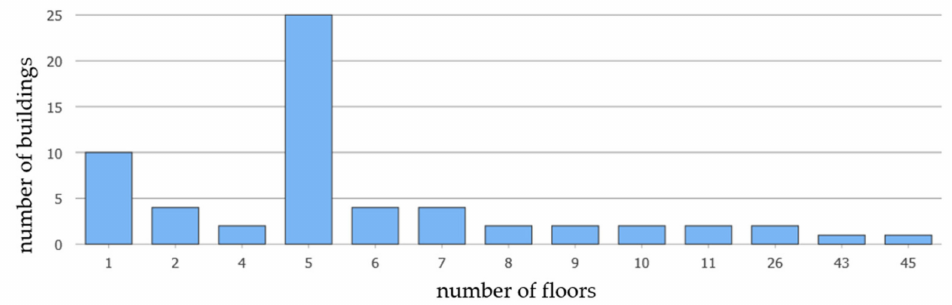
Figure 6. The number of buildings and number of floors of buildings in the vicinity of the Dworzec Centralny 08 tram stop, included in the analysis (source: study based on